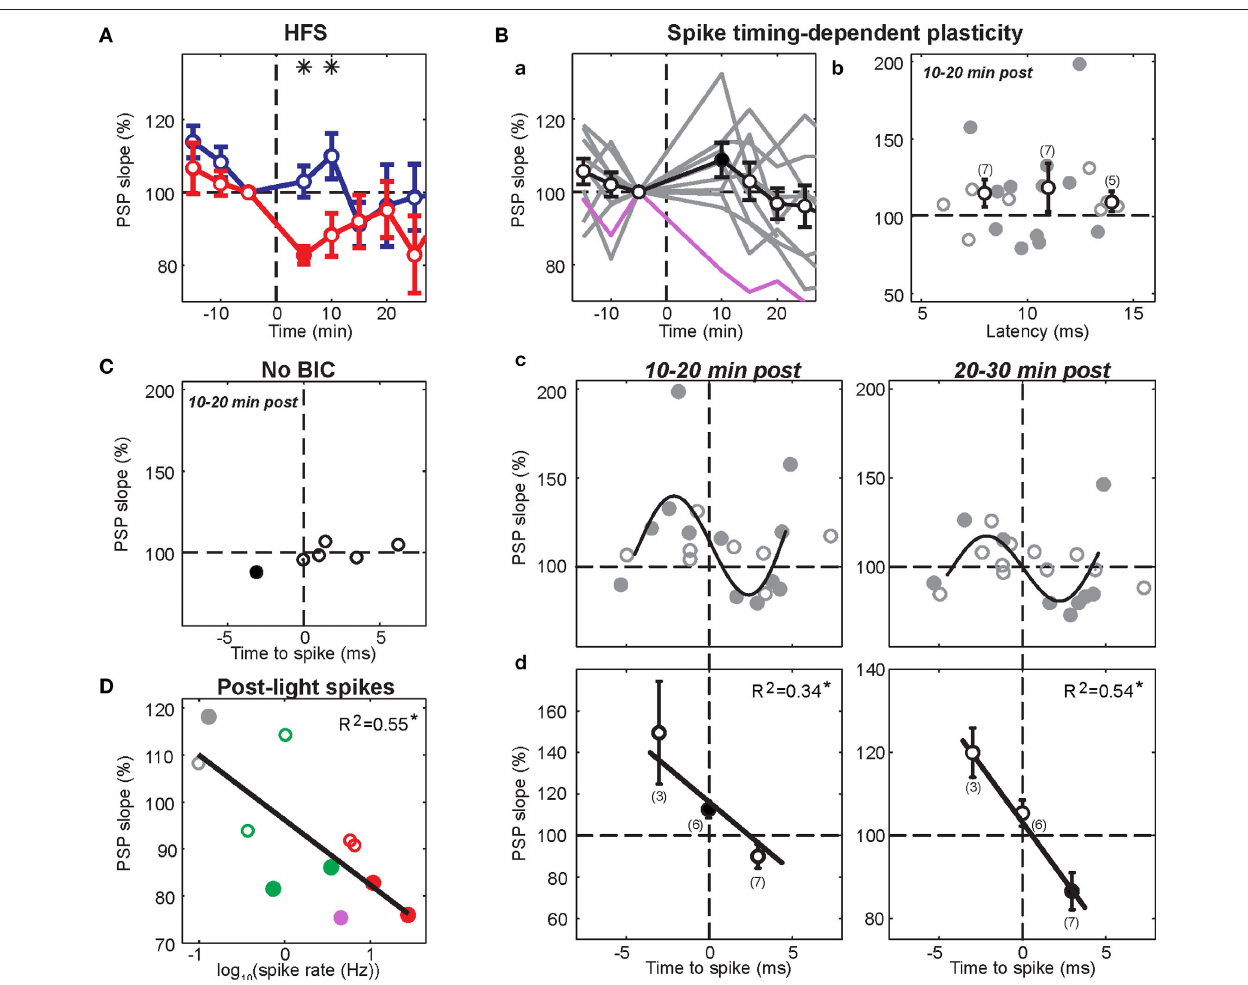
Figure 6 | Summary of cortico-striatal plasticity after visual activation of subcortical pathways. In all panels, significant changes from baseline are indicated by filled circles. (A) Effects of HFS on normalized PSP slope. Current-evoked spike discharge during visual inputs (red, n = 4) resulted in depression (asterisks; p < 0.05, t -test) when compared to current-evoked spike discharge during HFS (blue, n = 5). (B) Panel a, pre-post pairing resulted in variable outcomes across experiments (gray traces). One SPN (purple; same as Figure 4A ) was excluded because of a high post-light spike rate. Panels b–d, analysis of individual PSP components. Means (black) of binned data (3-ms bins; number of included points in brackets) indicate that changes did not depend on